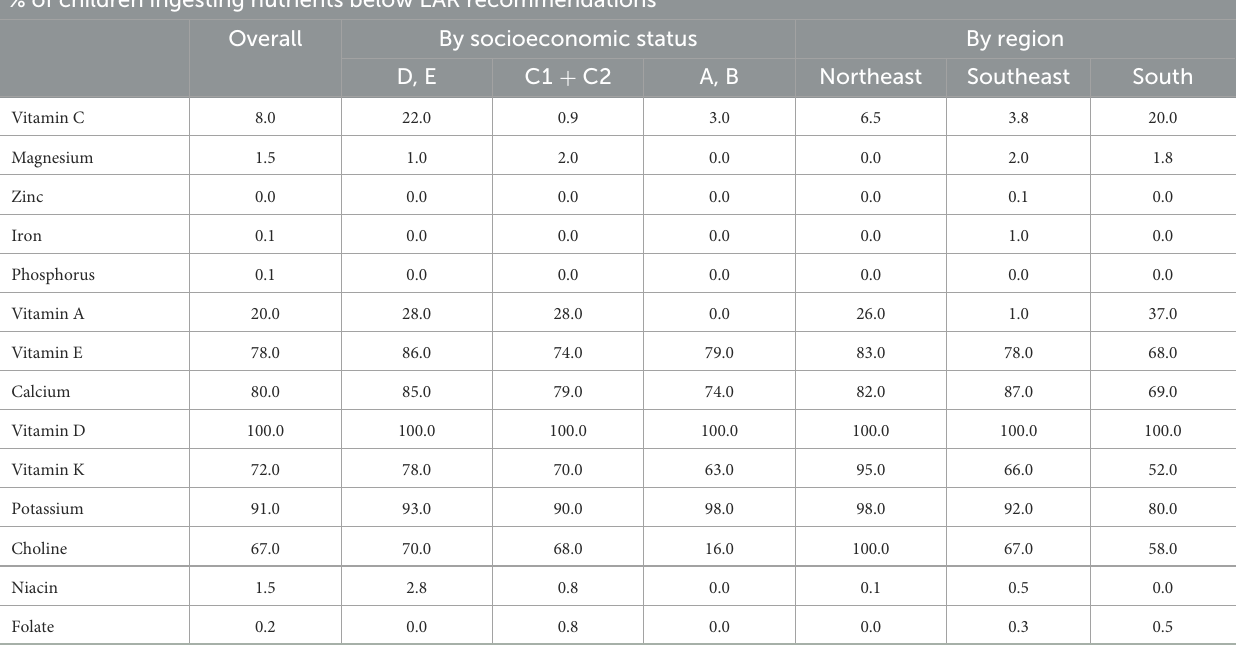
TABLE 2 Prevalence of inadequate intake of micronutrients by Brazilian children aged 4–8 years in the Northeast, Southeast, and South regions and according to socioeconomic status. % of children ingesting nutrients below EAR